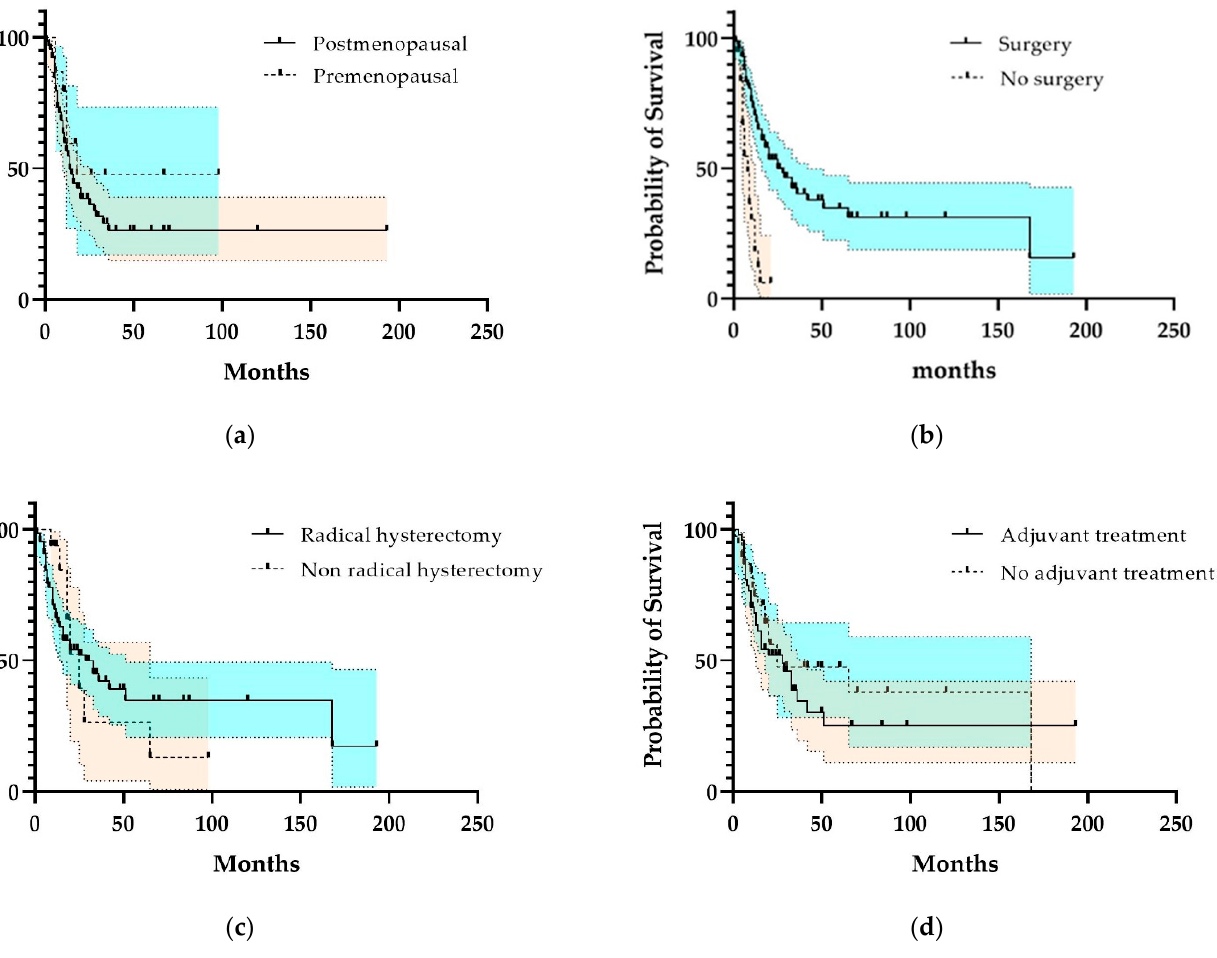
Figure 3. Kaplan–Meier survival curves for overall survival based on ( a ) menopausal status (postmenopausal vs. premenopausal), ( b ) management type (surgery vs. no surgery), ( c ) hysterectomy type (radical hysterectomy vs. non radical hysterectomy) and ( d ) supplementary treatment (adjuvant treatment vs. no adjuvant treatment). The prognosis was significantly improved following surgical management (including all types of surgical approaches) ( p < 0.0001). The menopausal status, hysterectomy type and use of supplementary treatments were not associated with statistically significant differences in overall survival.